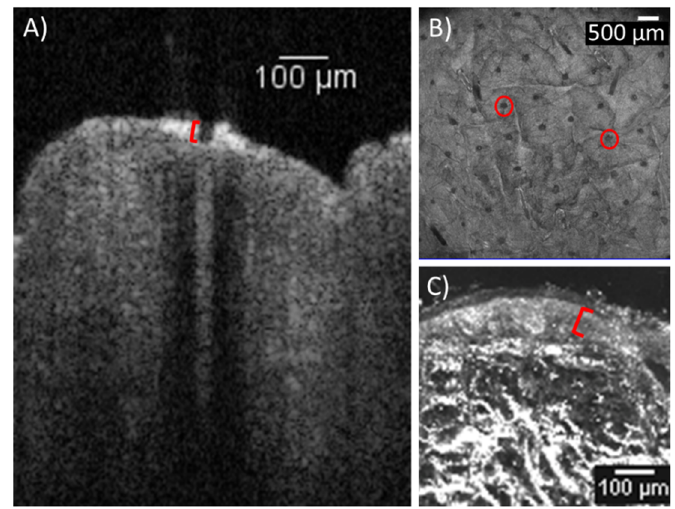
Figure 1. Laser channels and epidermis. Porcine skin treated with ablative fractional CO 2 laser at 2.5 mJ/mb, 5% density and 250 Hz at an area of 10 × 10mm. ( A ) Vertical OCT image showing an example of a laser channel (marked in red). The median depth of the channels reached 31.9 µ m into the epidermis ( n = 18). ( B ) Horizontal OCT image of the skin surface showing the grid of laser channels penetrating the skin (examples marked in red). ( C ) Ex vivo confocal microscopy image displaying close-up of the epidermis (marked in red). Epidermal thickness was measured to a median of 70.3 µ m ( n = 42). OCT: optical coherence tomography.